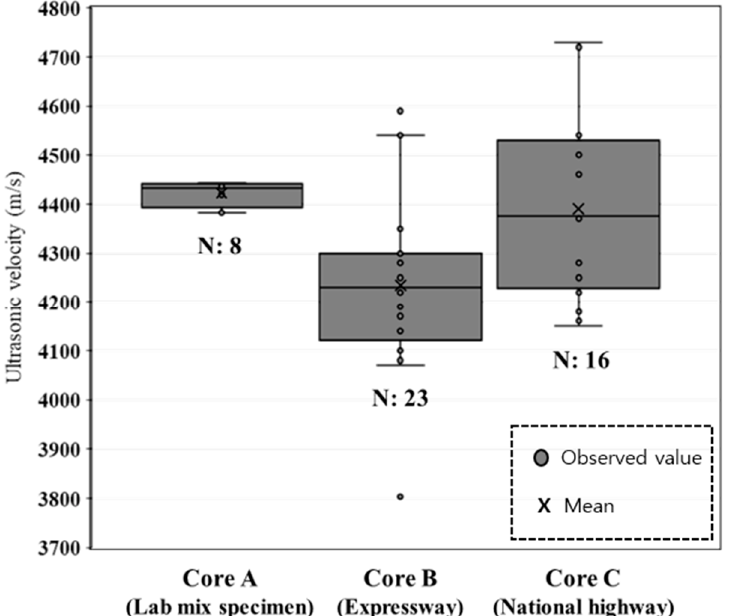
Figure 7. Results for concrete soundness grade standard “good” using ultrasonic velocity.